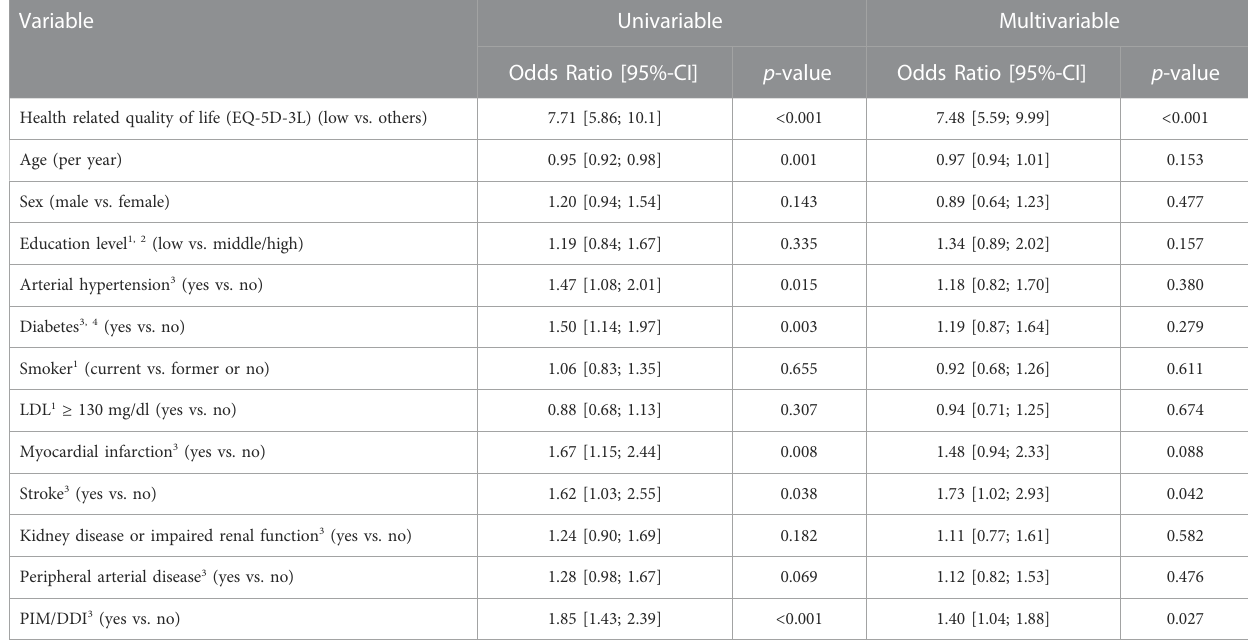
TABLE 5 Univariable models and multivariable model for the secondary endpoint lowHROQL 2 years after PIM/DDI baseline measured by the EQ-5D-3L (1,322 patients).